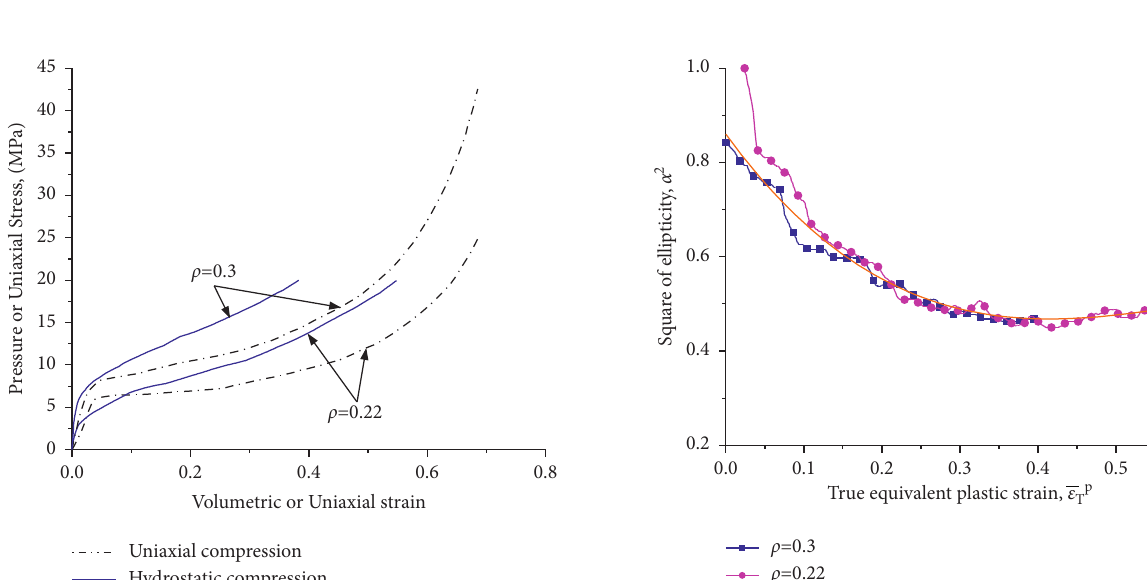
Figure 16: Predictions of biaxial loading conditions by the D-F model and the modified D-F model when the velocity ratio of three principal stress directions is (a) 1:1:- and (b) 2:1:-.